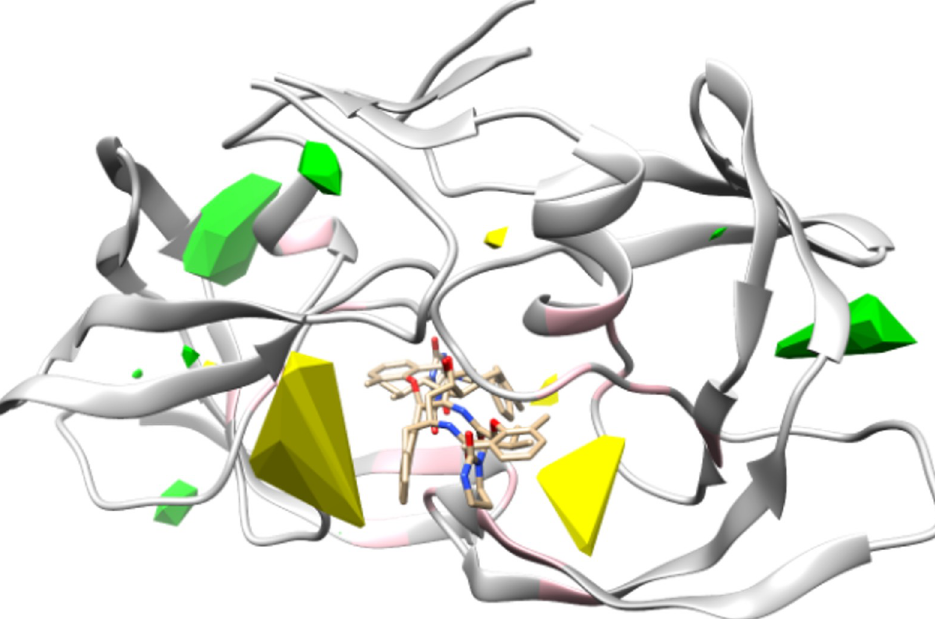
Fig 4. Contour map of steric effects in drug resistance acquisition. Contours were generated based on PLS standardized partial regression coefficients. Yellow and green contours indicate 1 st and 99 th percentiles of standardized partial regression coefficients, respectively. Steric interaction of the protease with yellow regions negatively affects drug resistance acquisition, whereas green regions show a positive effect. Dimerized wild-type HIV-1 protease (gray ribbon) and lopinavir (wireframe) are shown in the same figure. Pink indicates amino acids involved in drug resistance.